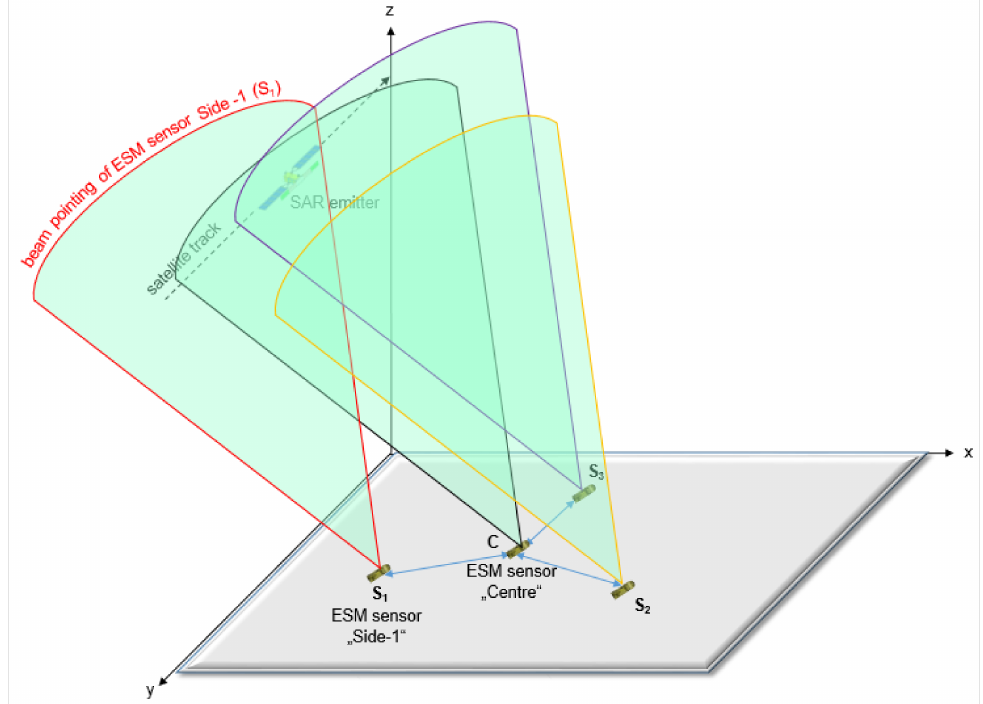
Figure 3. Deployment of ESM MLAT system consisting of four ESM sensors which recce the sky, where the targets of interest occur. The setting of the beam pointing of individual ESM sensors is addressed in the article